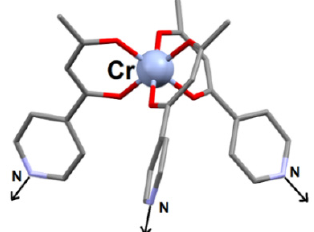
Figure 3. Crystal structure of the neutral metalloligand fac -[Cr III L 3 ] [where LH = 1-(4-pyridyl)butane- 1,3-dione)] showing the tripodal arrangement of its 4-pyridyl groups. Arrows indicate the coordination vectors of the pyridyl nitrogens [107].